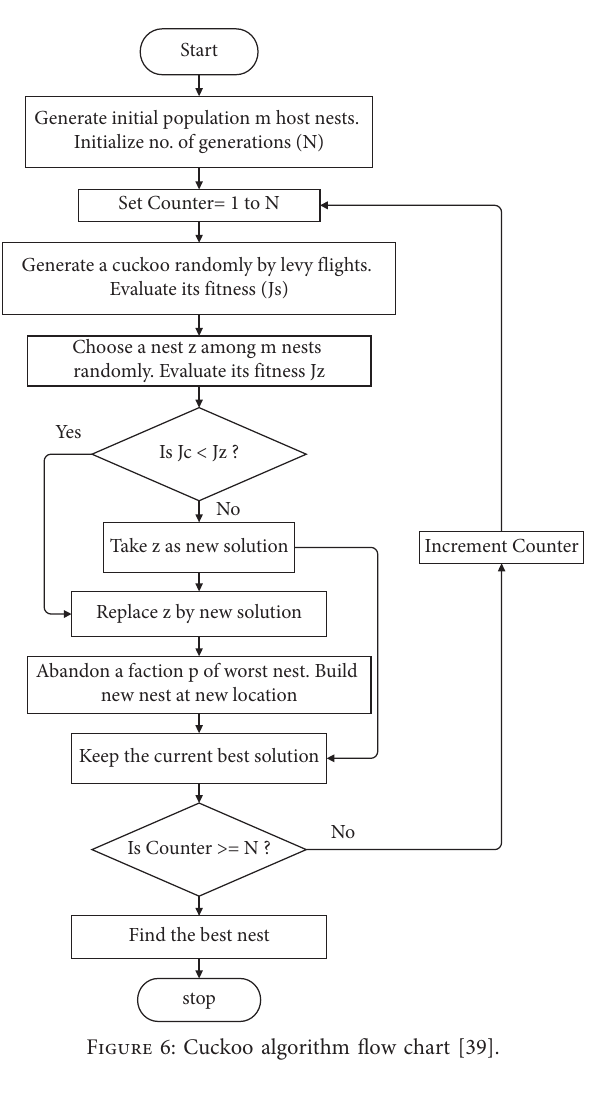
Figure 6: Cuckoo algorithm flow chart [39].